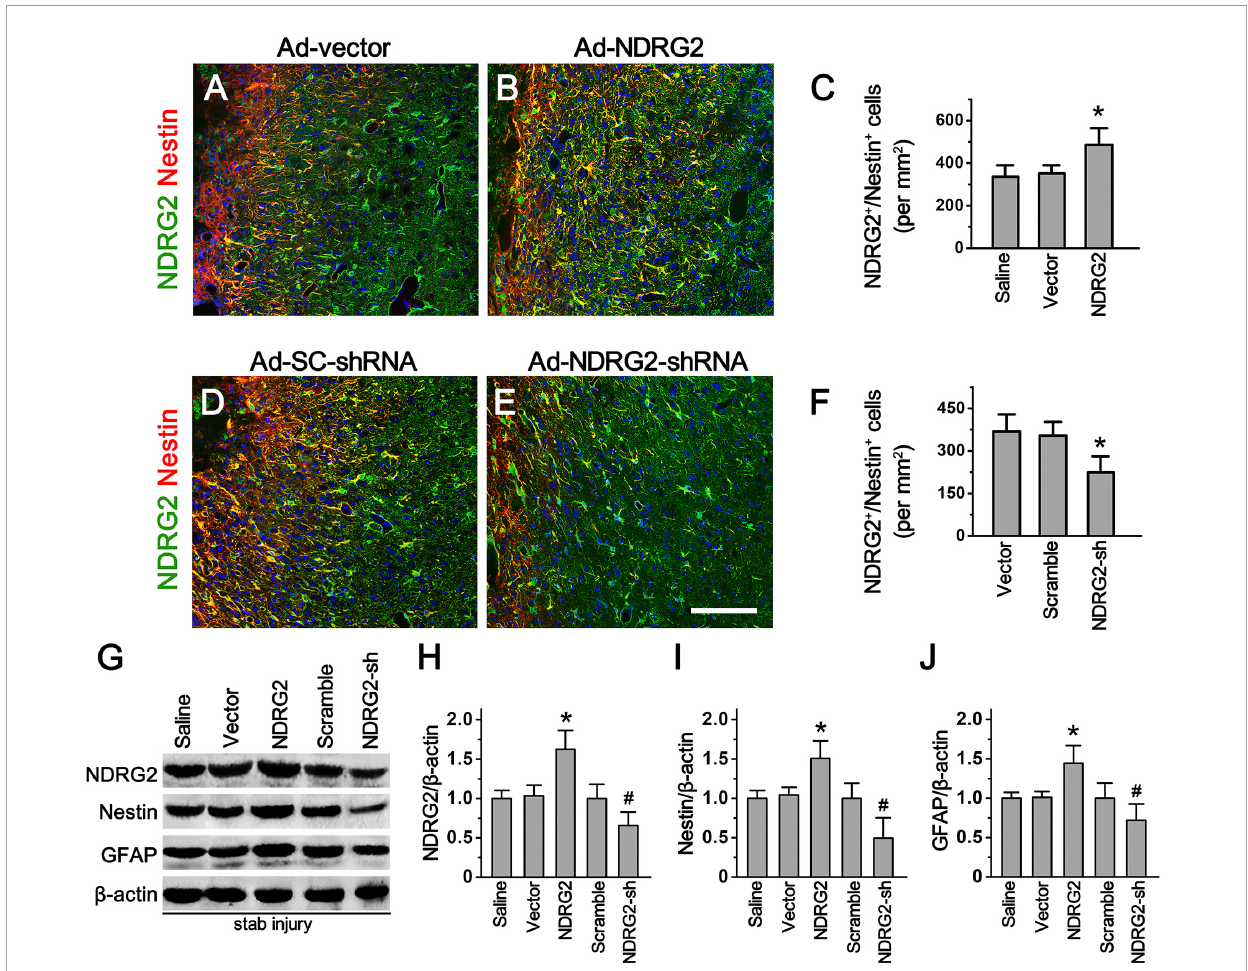
FIGURE3 NDRG2 controls the formation of Rad-PCs. (A–F) At 7 day after stab injury, double immunostaining of NDRG2 (green) and Nestin (red) was performed. Adenovirus-mediated NDRG2 overexpression (Ad-NDRG2) significantly elevated the number of NDRG2 + /Nestin + cells around the wound (B) . Quantified data are presented in panel (C) . Data are shown as mean ± SEM ( n = 5). * p < 0.05, vs. the blank vector (Ad-vector) and saline control. (D–F) Knockdown of NDRG2 expression by adenovirus-based shRNA (Ad-NDRG2-shRNA) decreased the number of NDRG2 + /Nestin + cells. Quantified data are presented in panel (F) . Data are shown as mean ± SEM ( n = 5). * p < 0.05, vs. the scramble (Ad-SC-shRNA) and blank vector control. Cell nuclei were counterstained with Hoechst33342 (blue). Scale bar in panel (E) : 100 µ m. (G–J) Immunoblotting analysis showed that NDRG2 overexpression (NDRG2) upregulated the expression of NDRG2, Nestin and GFAP while knockdown of NDRG2 expression (NDRG2-sh) downregulated the expression of these factors. β -actin was used as an internal control. Quantified data are presented in panels (H–J) . Data are normalized to the saline control and shown as mean ± SEM ( n = 4). * p < 0.05, vs. the vector control; # p < 0.05, vs. the scramble